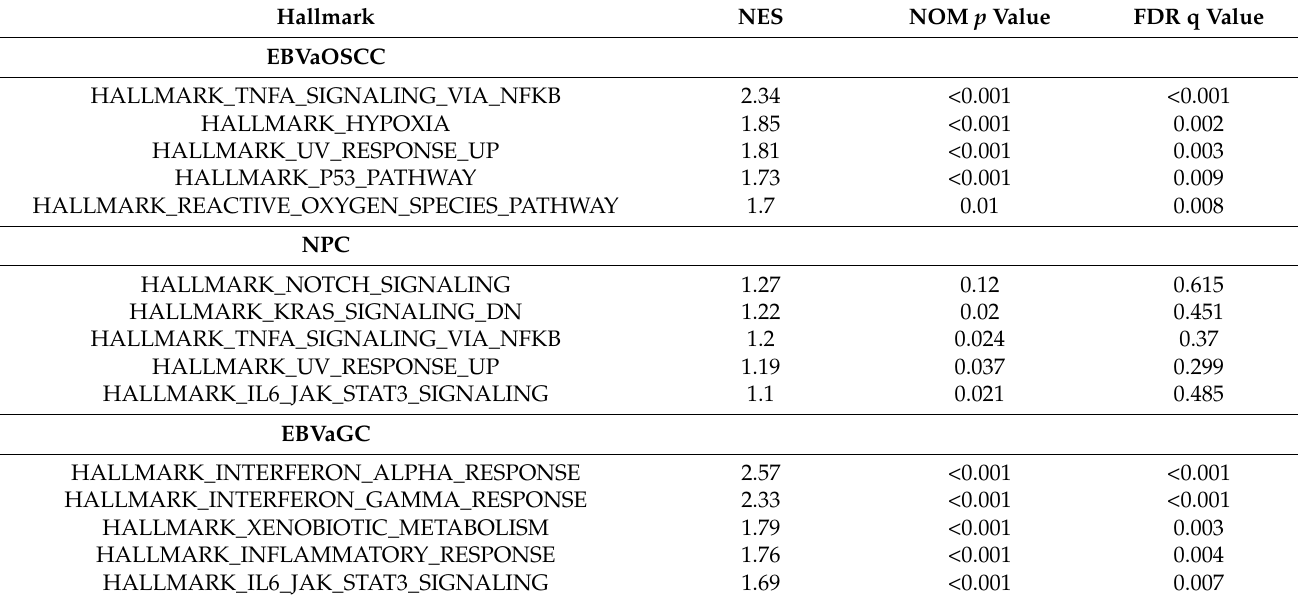
Table 2. Top 5 hallmarks in EBVaOSCC, NPC, and EBVaGC. Hallmark NES NOM p Value FDR q Value EBVaOSCC